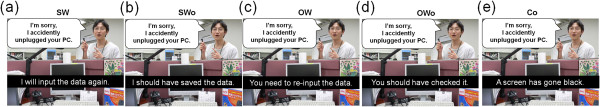
Example of a stimulus set. (a) The SW response describes the subject’s own behavior in the near future. (b) The SWo response describes the subject’s own behavior in the past. (c) The OW response describes another’s behavior in the near future. (d) The OWo response describes another’s behavior in the past. (e) The Co (control) condition only describes the situation.